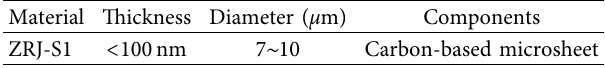
Table 2: Physical properties of ZRJ-S1